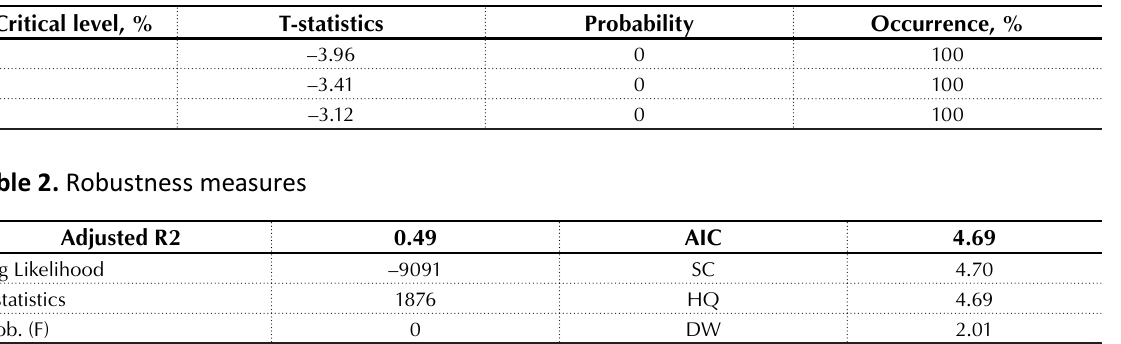
Table 1. The augmented Dickey-Fuller test